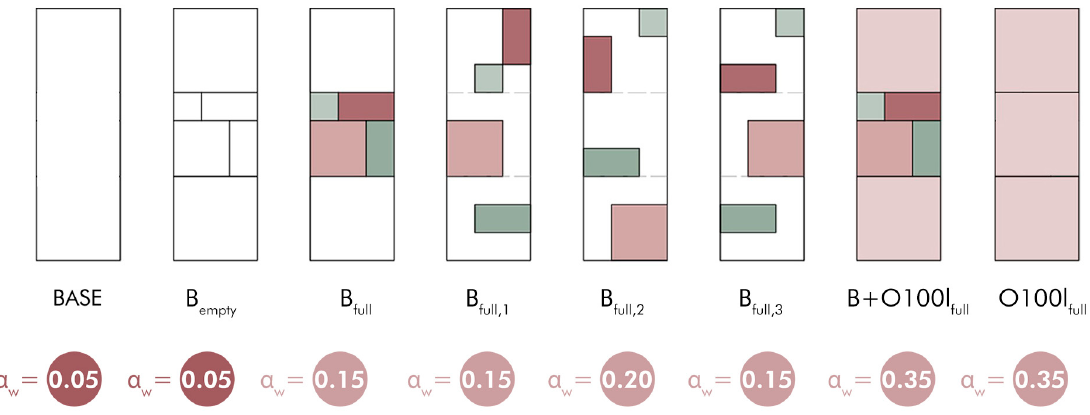
Figure 14. Weighted sound absorption coefficient of the various configurations presented in Fig- ure 5.